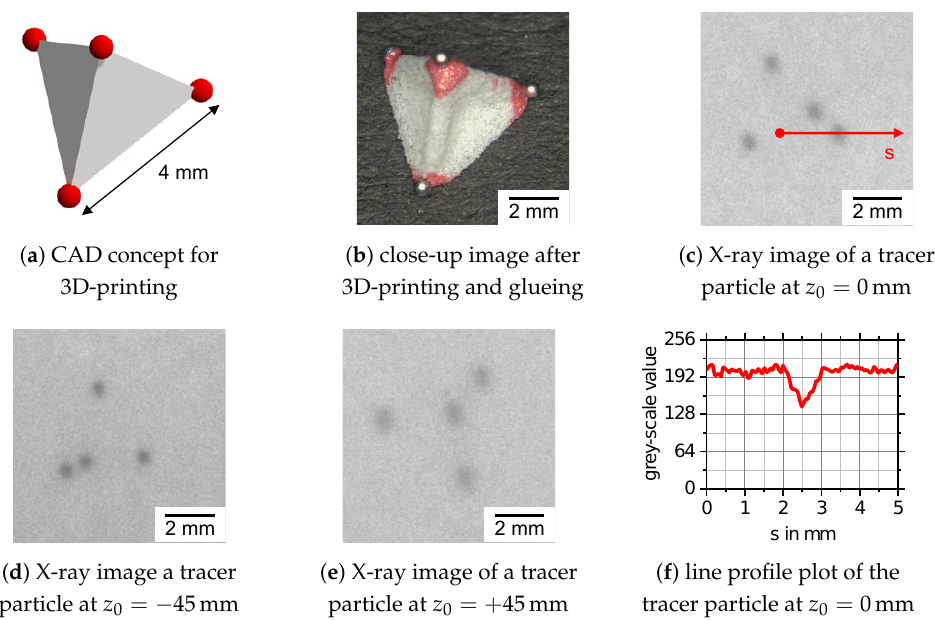
Figure 4. Custom-tailored tracer particles: ( a ) based on the CAD concept, small tetrahedra were 3D- printed from polymer material and ( b ) small metal beads were glued to the tips of each tetrahedron. ( c – e ) In the X-ray images, only the four metal beads per tetrahedron are visible, ( f ) which can be clearly distinguished from the surrounding liquid foam and from the statistical image